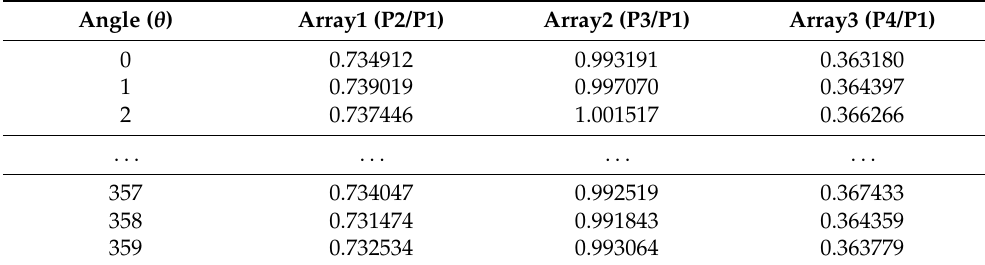
Figure 2. Sensor ratio diagram. Table 1. Sensor ratio